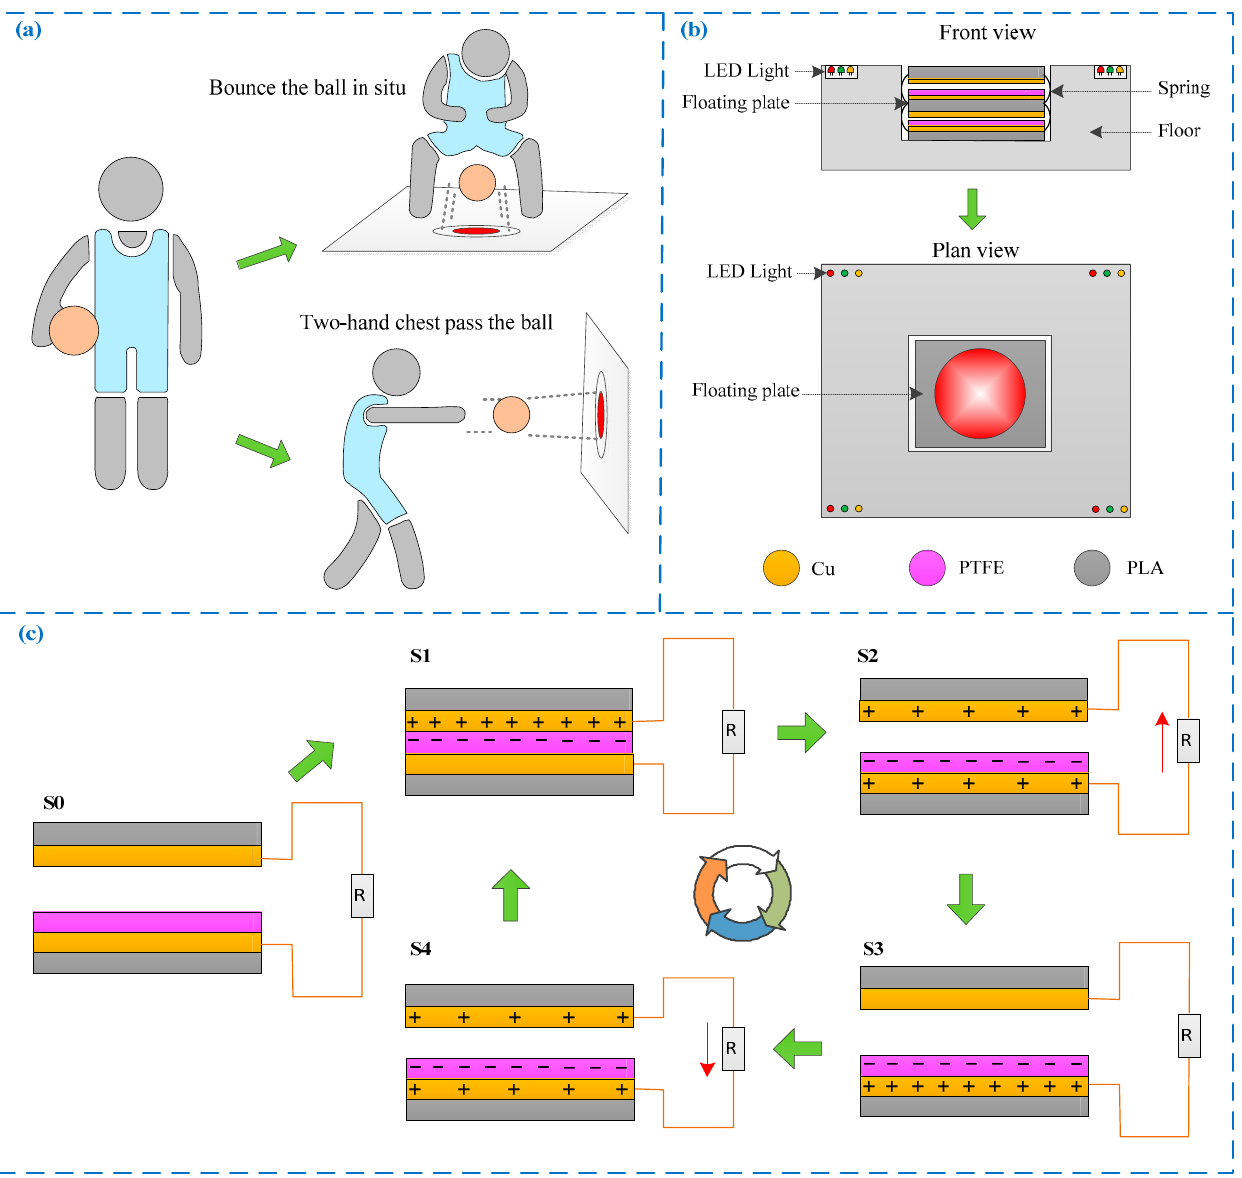
Figure 1. Composition and working principle. ( a ) Schematic diagram of “bounce the ball in situ” and “two-hand chest pass the ball”; ( b ) schematic diagram of the sensor structure; ( c ) schematic diagram of the sensor working steps. PTFE, polytetrafluoroethylene.